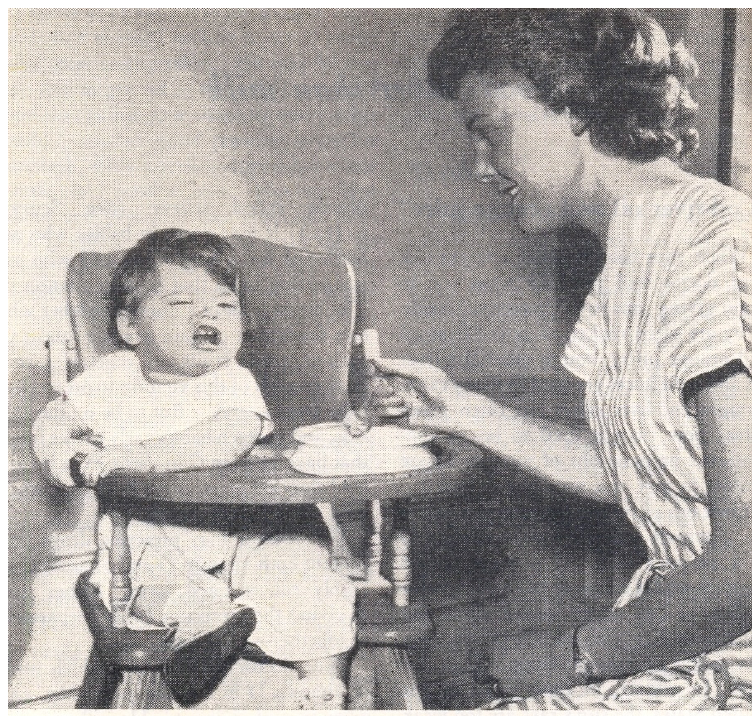
Figure 12. Photo of Baby Being Fed in Highchair.